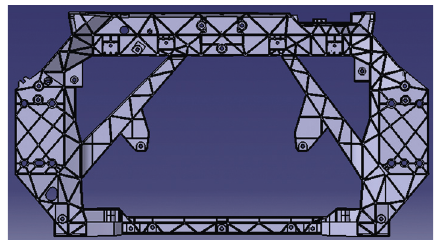
Figure 12: Front-end frame structure of the vehicle.